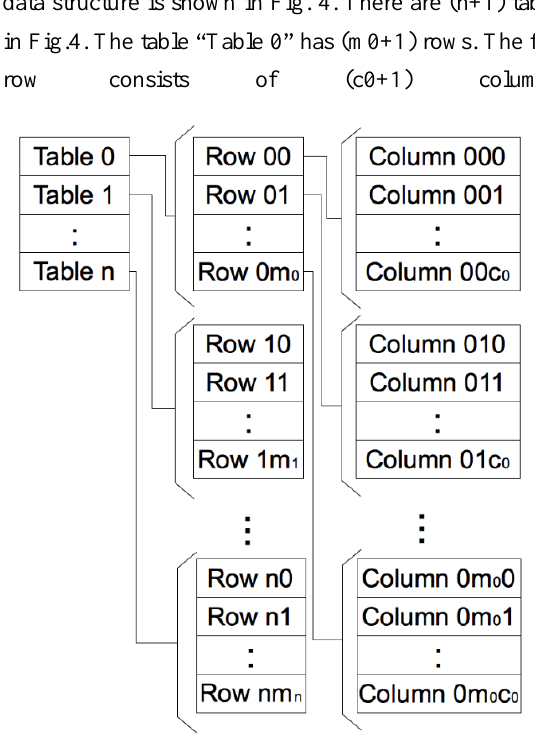
Fig. 4. Data structure.